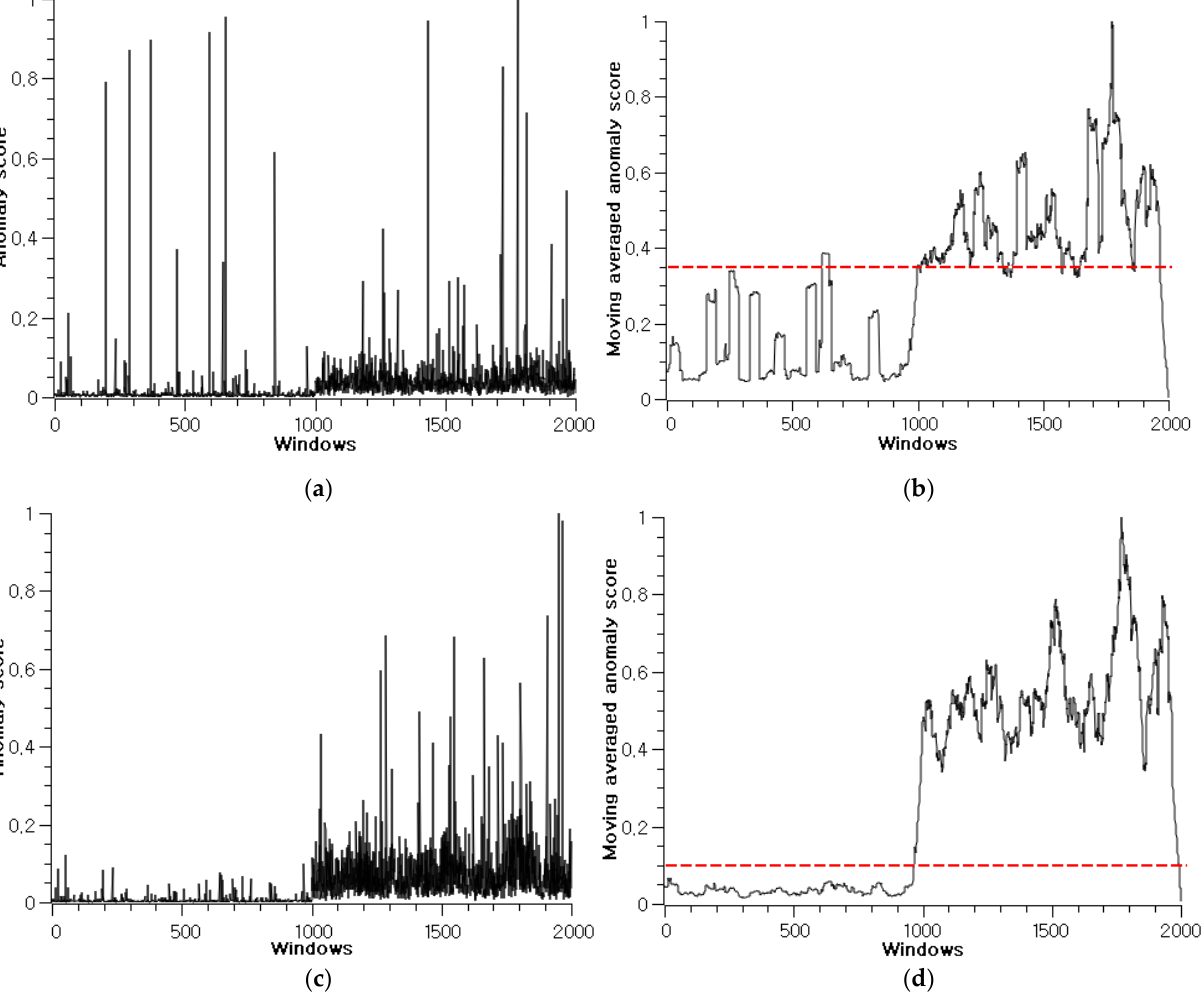
Figure 9. The anomaly score of scenario 11 for healthy condition (0–1000) and faulty condition (1001–2000) windows. The score shows low values for the healthy condition until the 1000th window, and the values become high for the unhealthy windows after the 1000th window. The red dashed line represents the threshold limit: ( a ) Score of standard AAE; ( b ) Moving-averaged score of standard AAE; ( c ) Score of RaPP AAE; ( d ) Moving averaged score of RaPP AAE.